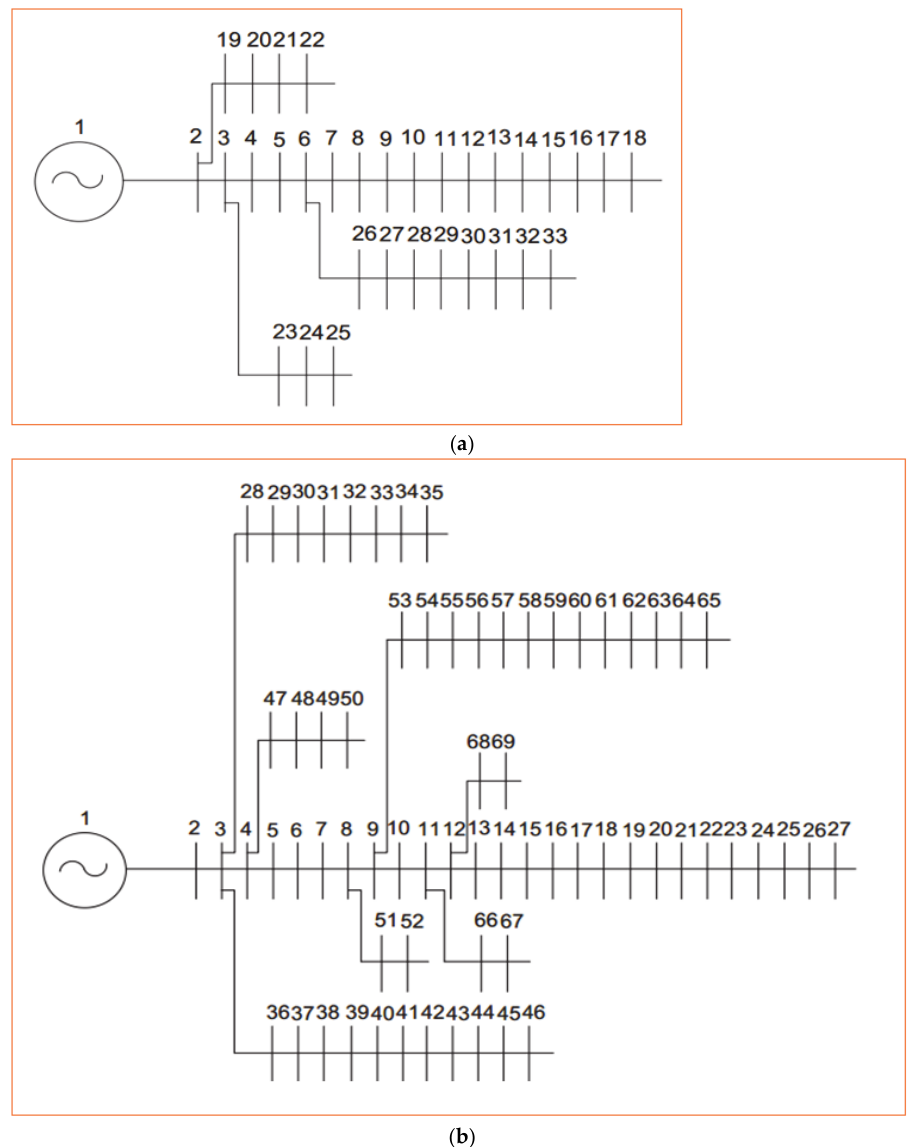
Figure 4. Schematic of IEEE: ( a ) 33 ‐ bus; ( b ) 69 ‐ bus radial distribution systems.